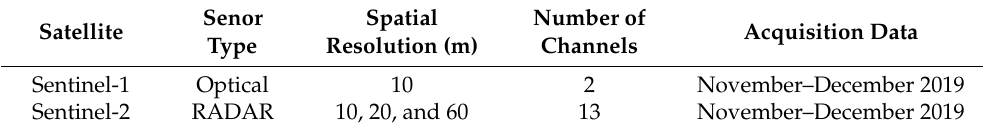
Table 2. Basic specifications of Sentinel-1/2